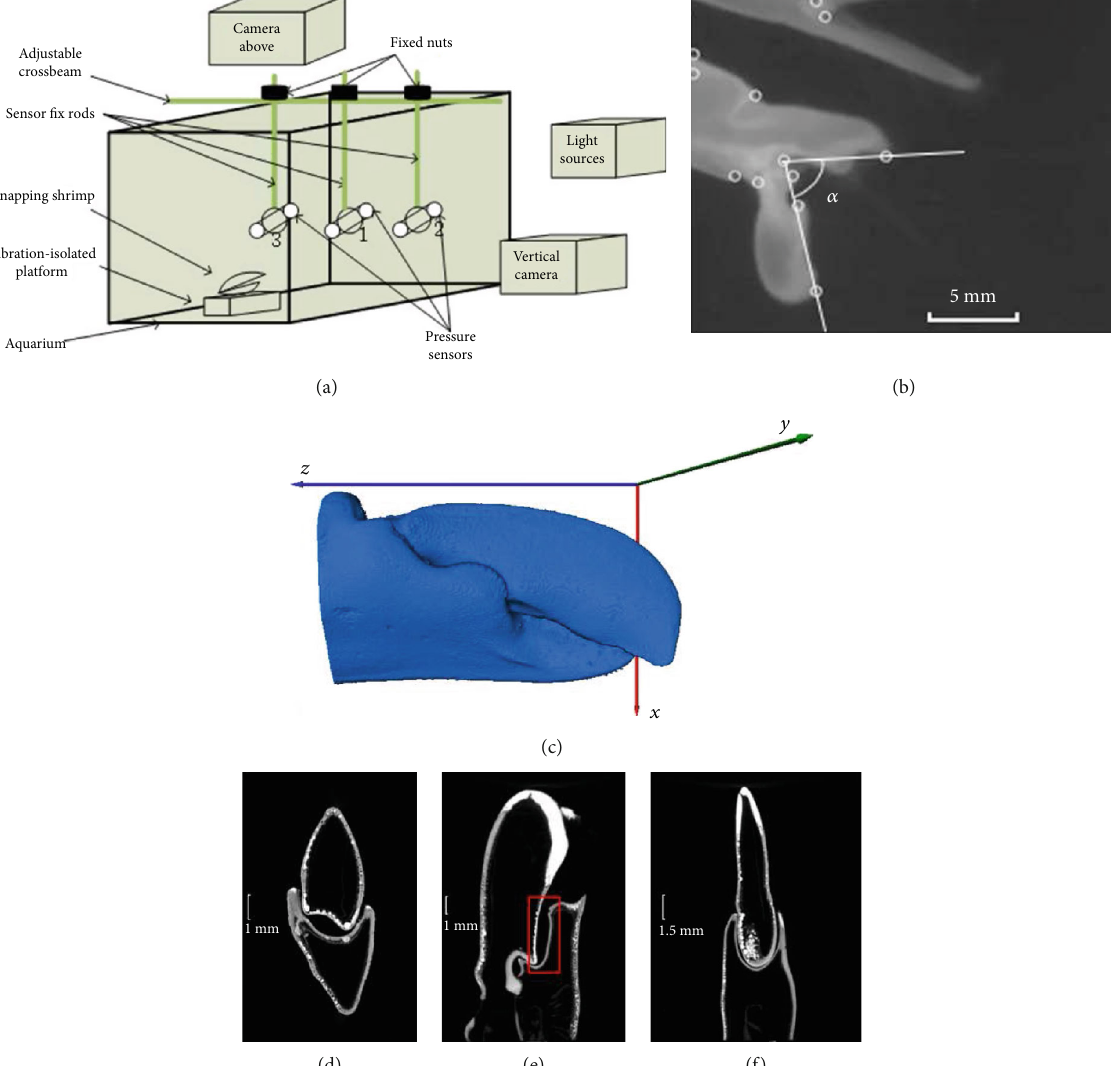
Figure 1: (a) Schematic view of the experimental device. The vibration-isolated platform is placed in the center of the aquarium, and the sensors are fi xed at a distance of 3 cm in front of the snapper claw. (b) Gray value image of the snapper claw from the side. The in fl ection points of the claw are marked by circles, and the opening angle is measured to be 82.4 ° . (c) 3D reconstructed model of snapper claw with a scale of 1 :1. (d) CT slices of shrimp claw in the x-y direction. The dactyl is inserted into the socket to form a cavity closed on both sides. (e) CT slices of shrimp claw in the x-z direction. The red rectangle indicates the cavity and nozzle structure. (f) CT slices of shrimp claw in the y-z direction. The dactyl is tightly surrounded by socket, representing a fi ne hermetic